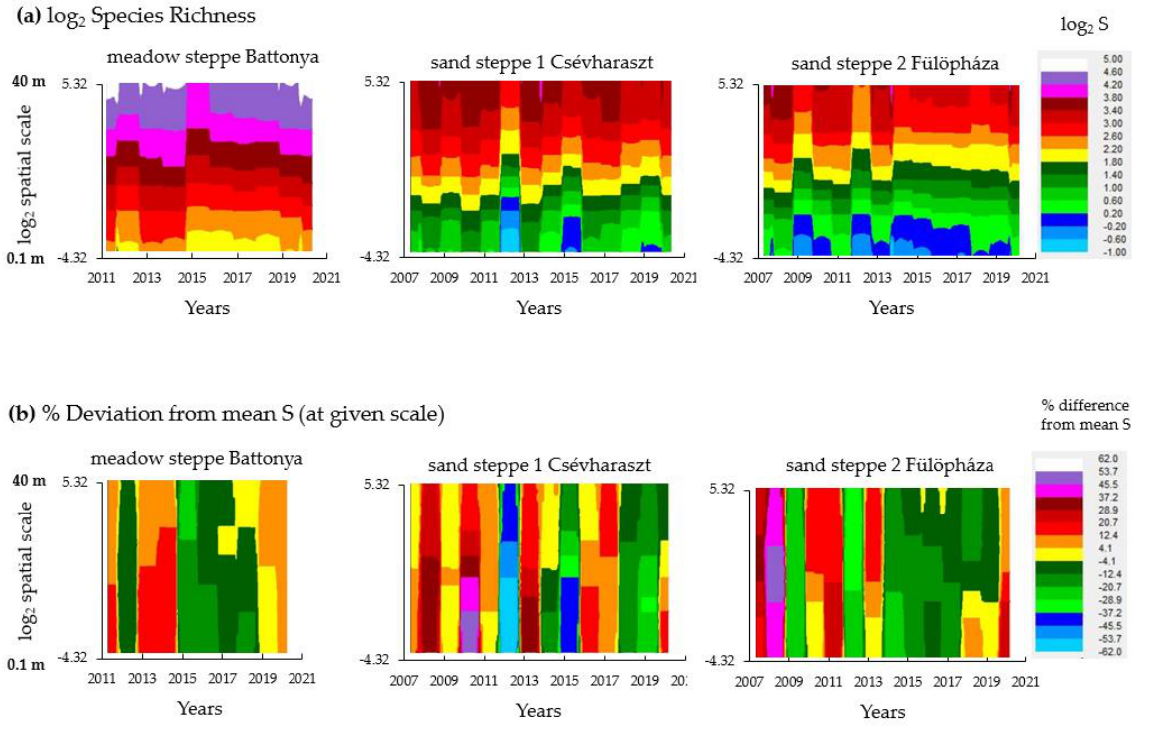
Figure 5. Spatial scaling of the temporal species richness patterns at continuously increasing scales.